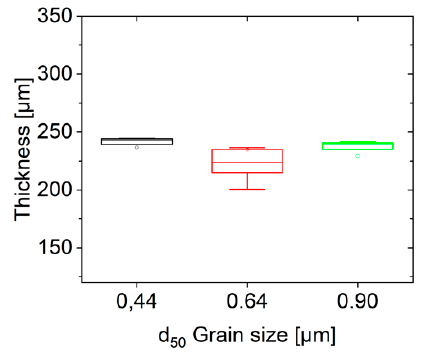
Figure 10. Thickness variation of the substrates of O1, HT1350 and HT1400 for different d 50 -grain sizes.